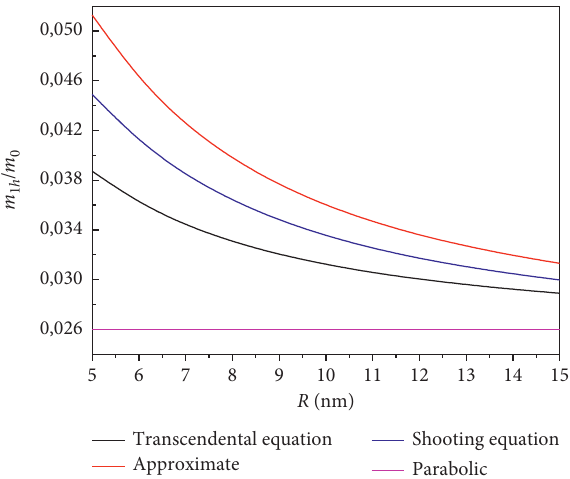
Figure 9: The dependence of the effective mass of a heavy hole on the radius of a cylindrical quantum wire with a finite potential. Figure 10: The dependence of the effective mass of a light hole on the radius of a cylindrical quantum wire with a finite